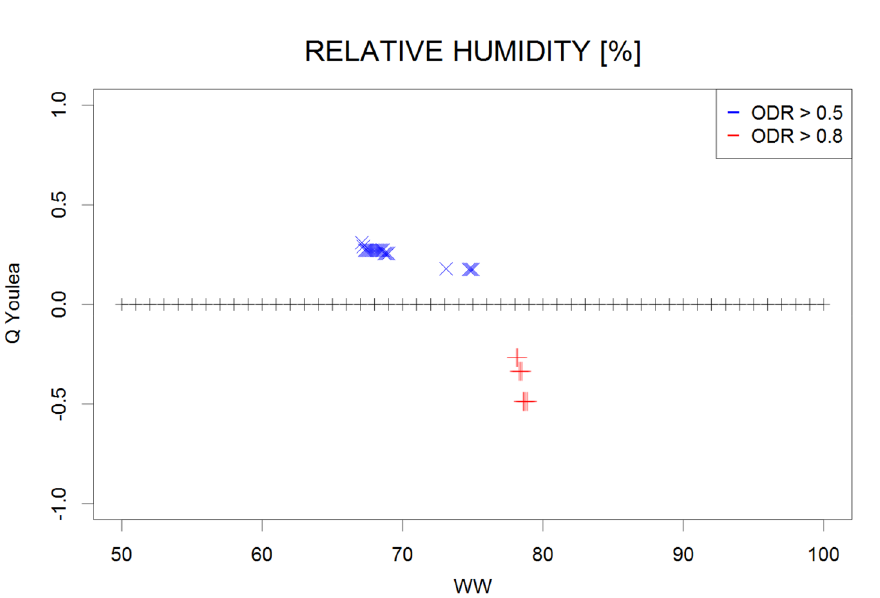
Figure 6. Plot of Q coefficients for different threshold levels of relative humidity (RH) for the investigated ODR limits (≥ 0.5 and ≥